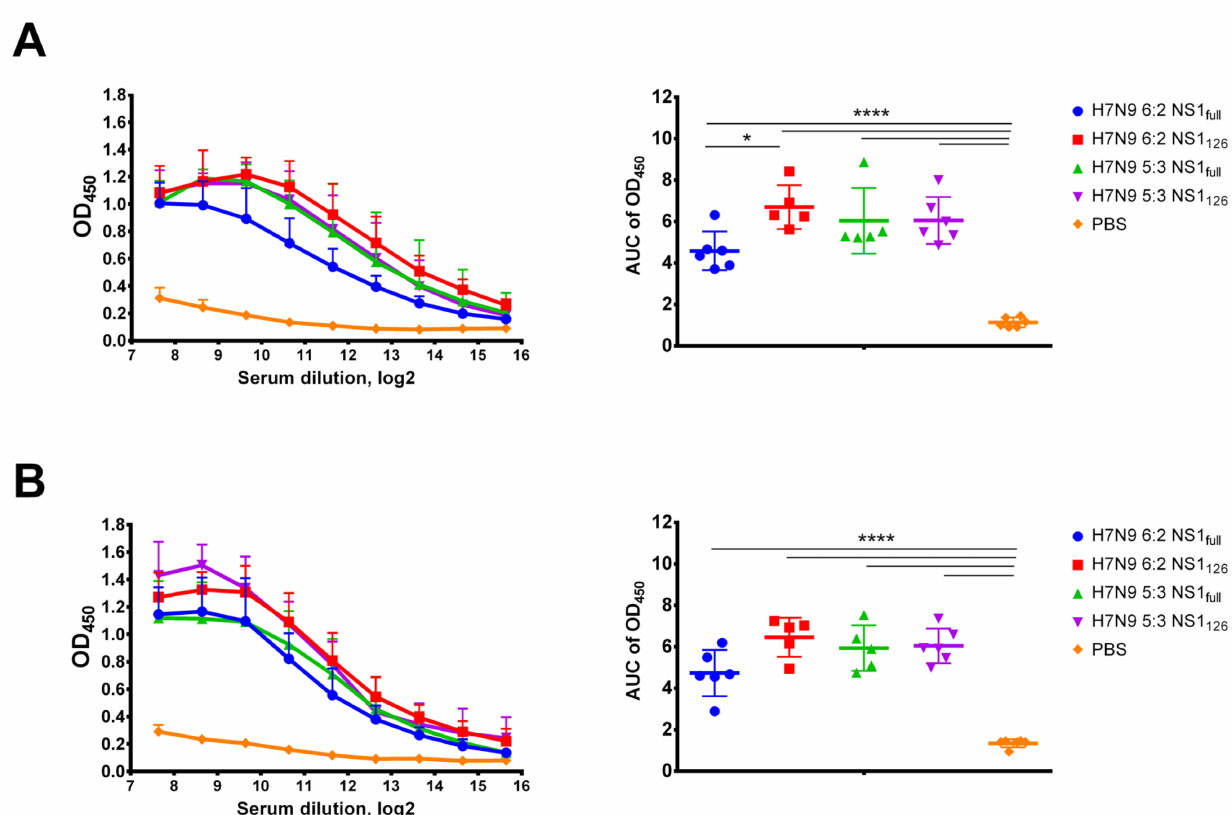
Figure 3. Serum IgG antibody immune responses to each LAIV candidate tested in this study. Mouse sera were collected three weeks after the second intranasal immunization. IgG antibody levels were assessed in ELISA with H7N9 6:2 LAIV whole virus ( A ) and H7N9 5:3 LAIV whole virus ( B ). Left panel shows mean OD 450 values for each serum dilution. Right panel shows the area under the OD 450 curve values for each individual animal. Data were analyzed by one-way ANOVA with Tukey’s post hoc multiple analyses test. * p < 0.05; **** p <